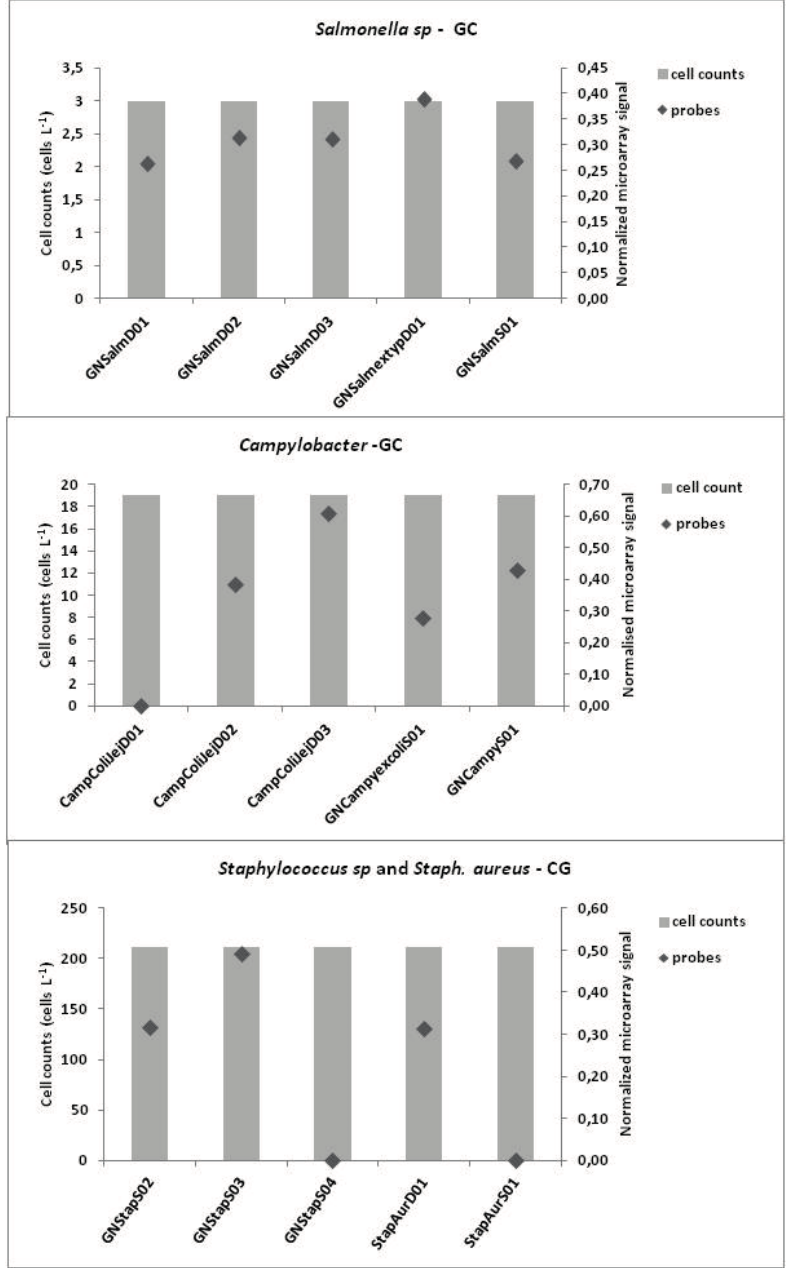
Figure 6. Comparison of concentrations of microorganisms and signal point measurement probes for each probe at the Castel Giubileo